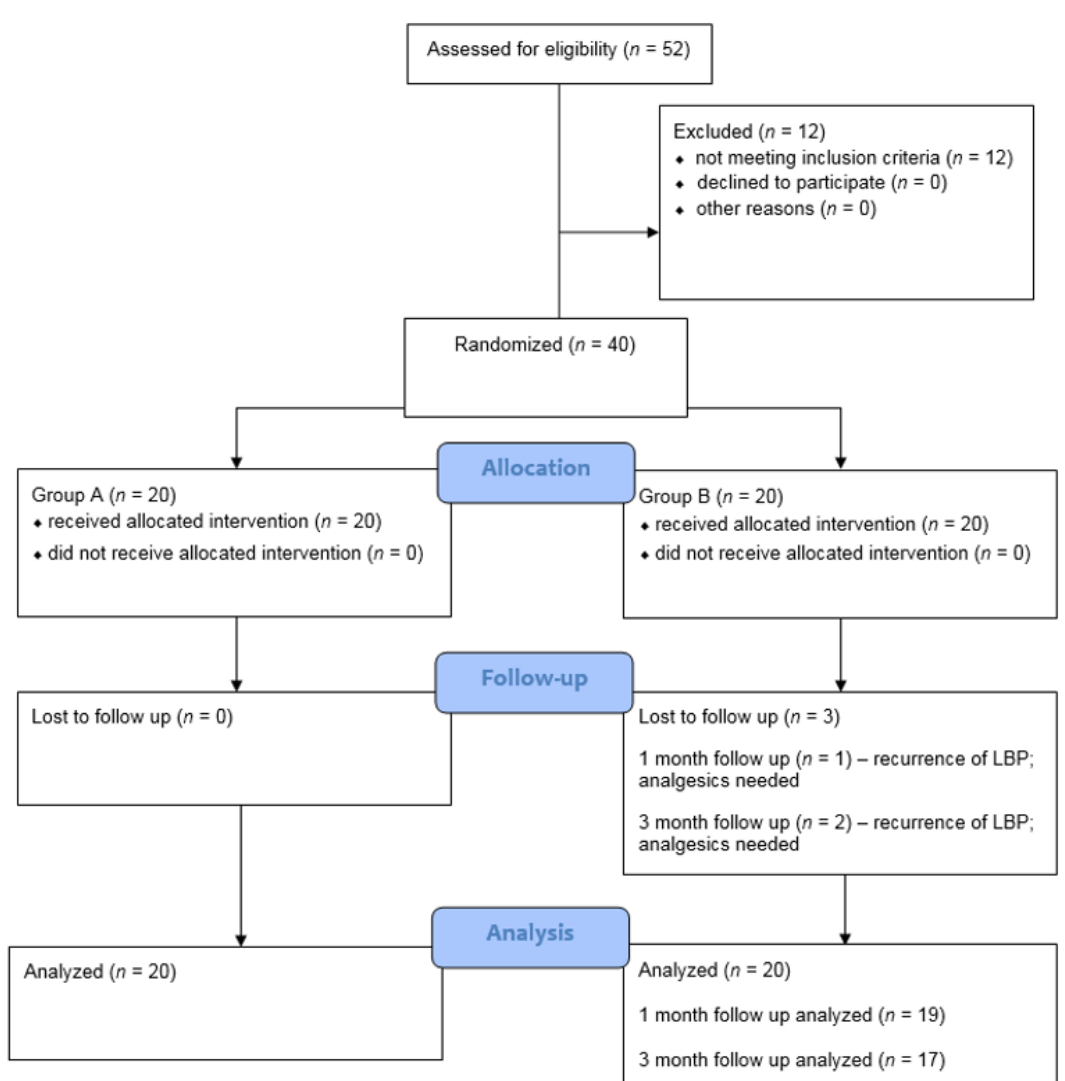
Figure 2. The CONSORT 2010 flow chart of patients in the study. Table 1. Characteristics of the participants included in the study.